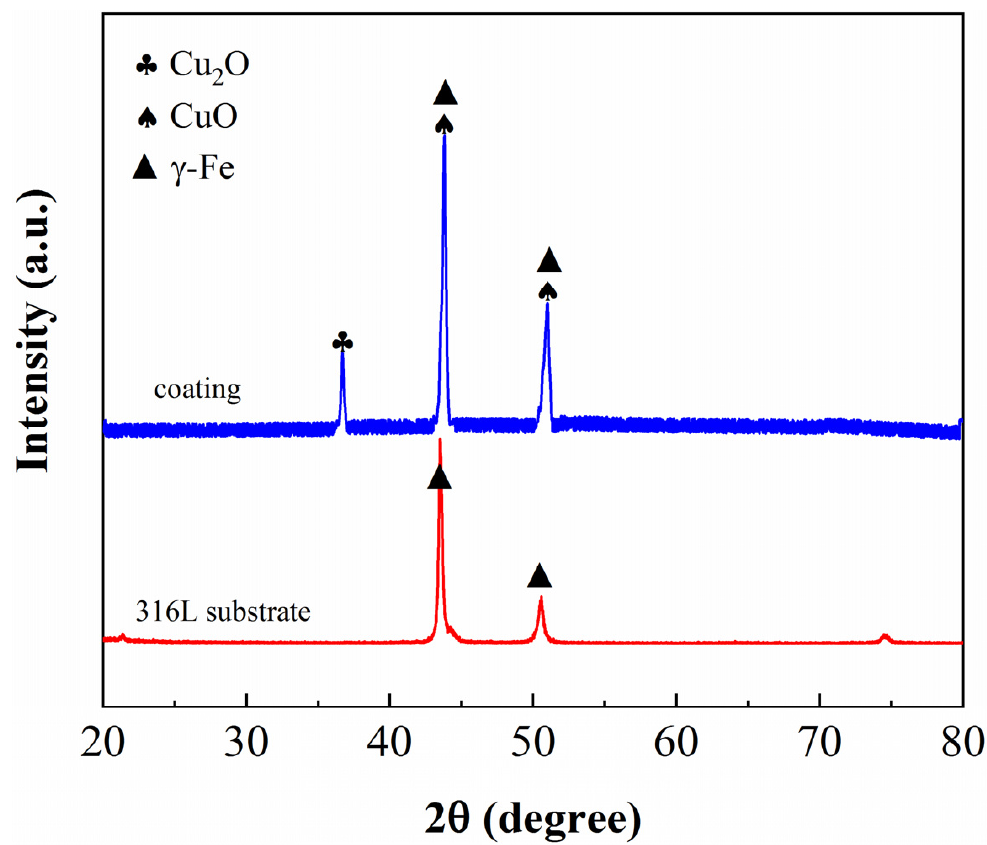
Figure 2. XRD spectra of the NPSS and Cu/NPSS samples.